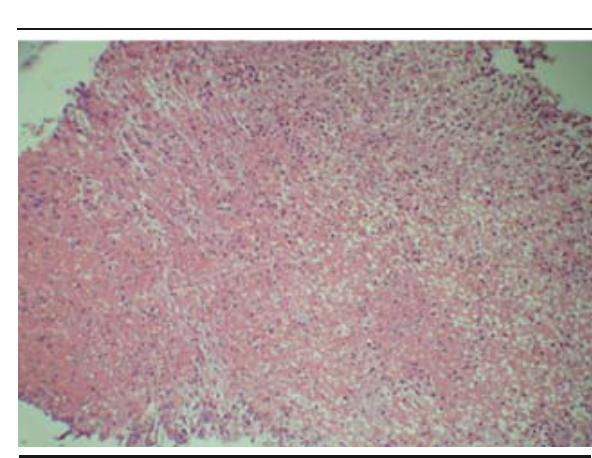
Figure 4. Section showing fibrinoid material with plenty of neutrophils which is compatible with ulcer